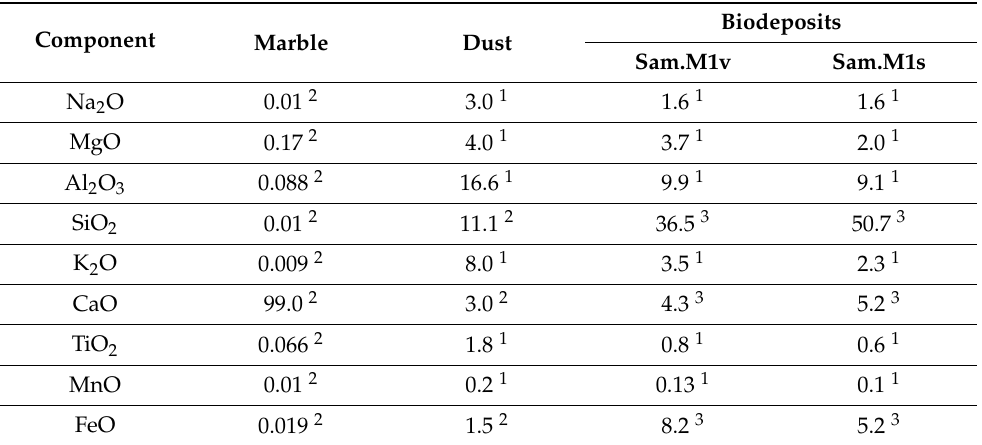
Table 5. Content of the main impurity elements (wt%) in Carrara marble and deposits (dust, moss and primary soil) on its